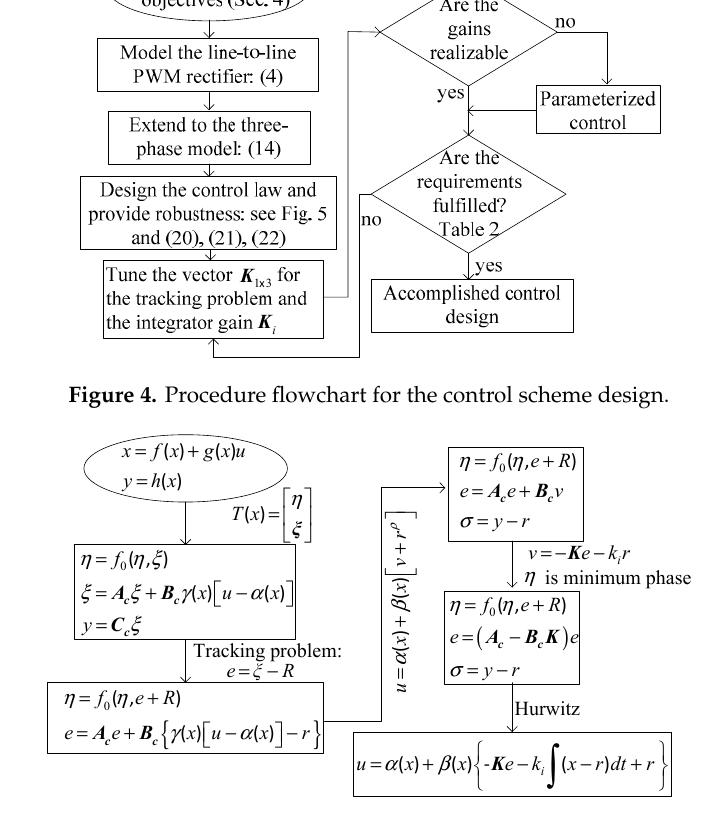
Figure 5. Procedure flowchart for the control law design.